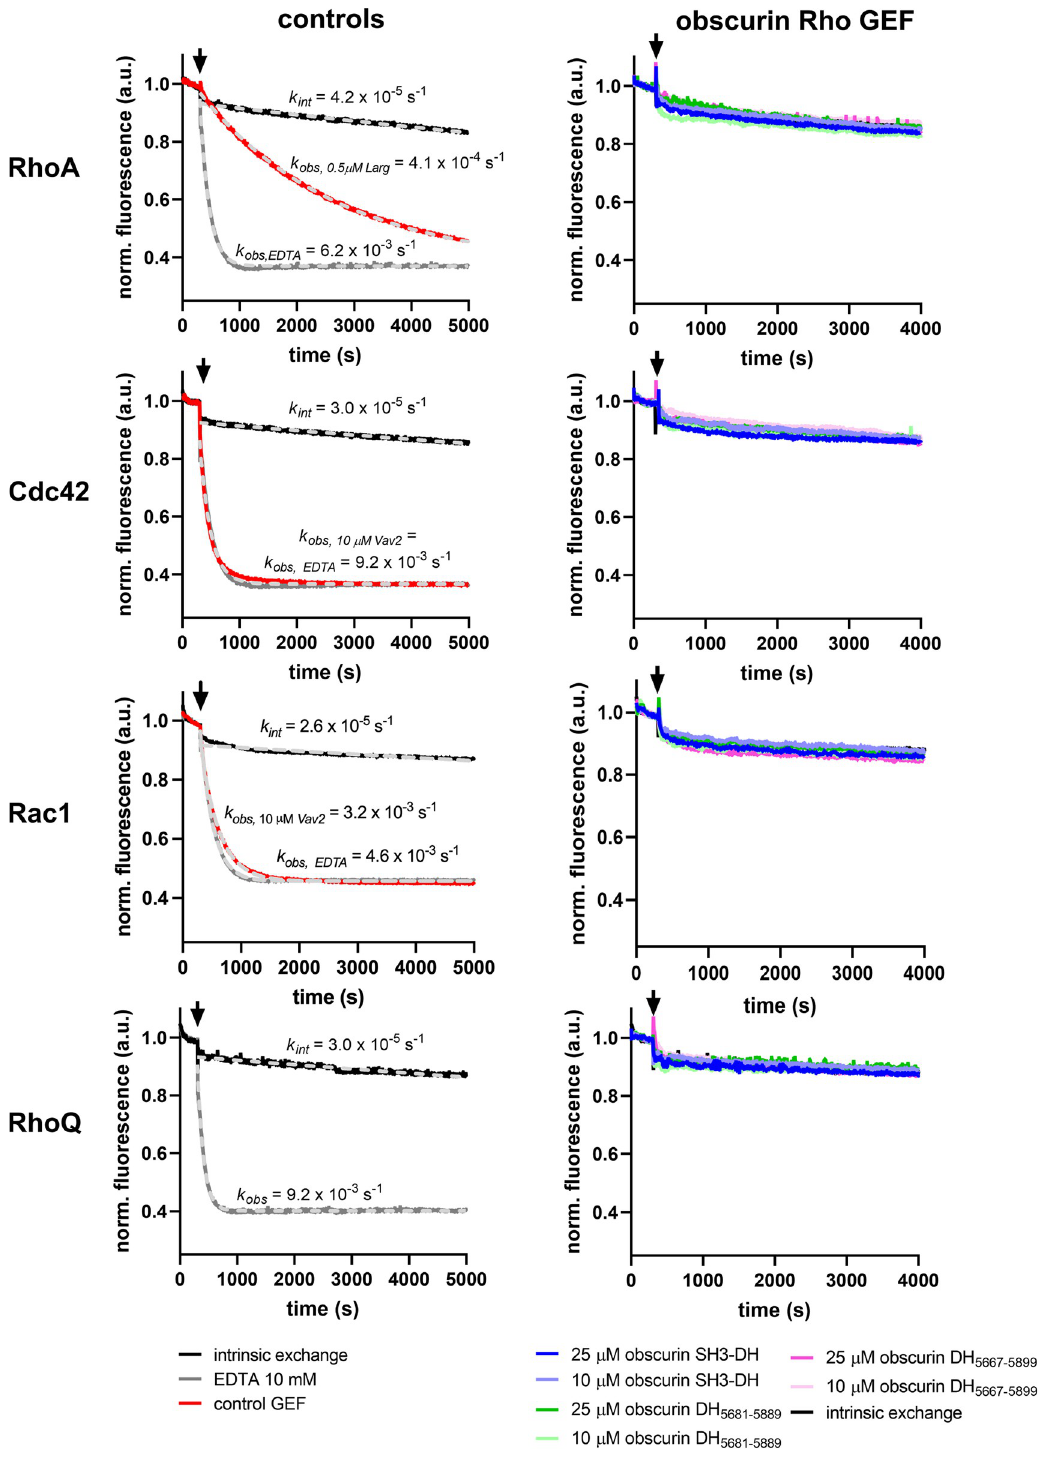
Fig 2. Guanosine nucleotide exchange factor activity of obscurin RhoGEF fragments towards RhoA, Cdc42, Rac1 and RhoQ/ TC10. Left panels show the intrinsic nucleotide activity as a negative control, EDTA and GEFs Vav2 and Larg as positive controls for each GTPase. Right panels show the nucleotide exchange activity after addition of obscurin. Black arrows indicate addition of buffer/GEF/EDTA. Data represent mean of n = 2–3 experiments.